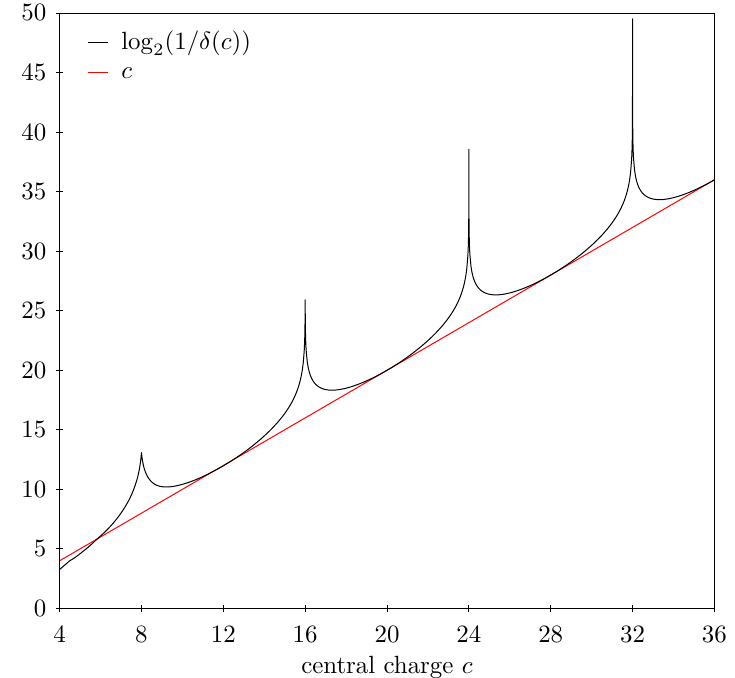
Figure 12 . The maximum δ ( c ) of | d LP